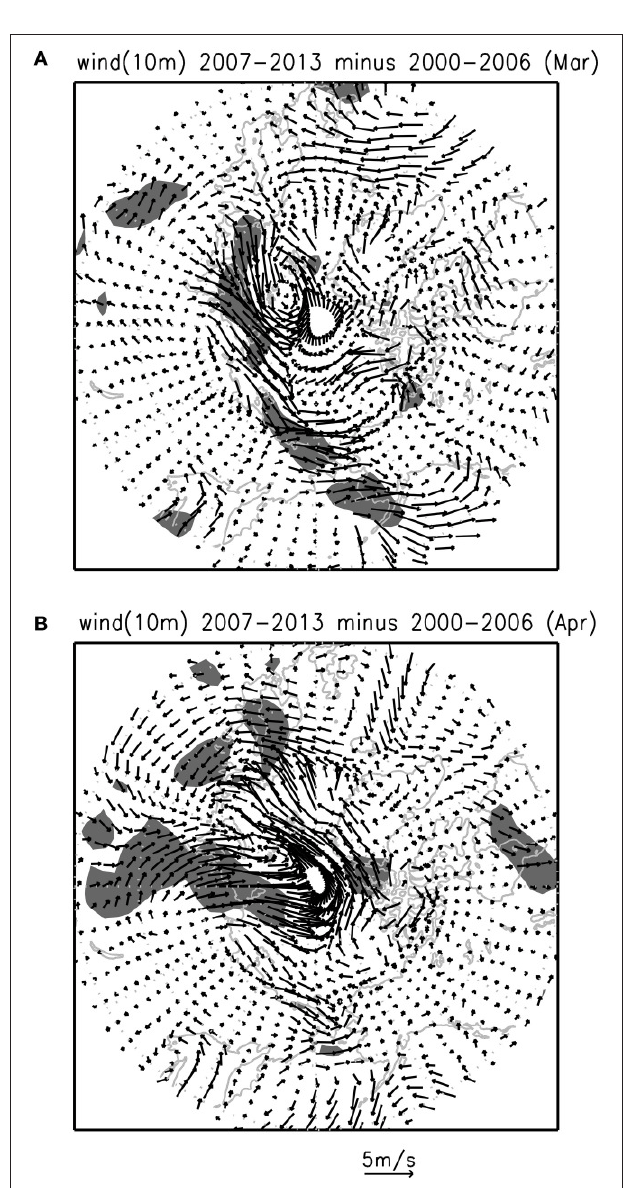
FIGURE 7 | Difference of surface (10 m) wind (m/s) in March (A) and April (B) derived as mean during 2007-2013minus that during 2000-2006. The shading denotes that the difference between 2007–2013 and 2000–2006 is significant at the 95% confidence level according to the Student t